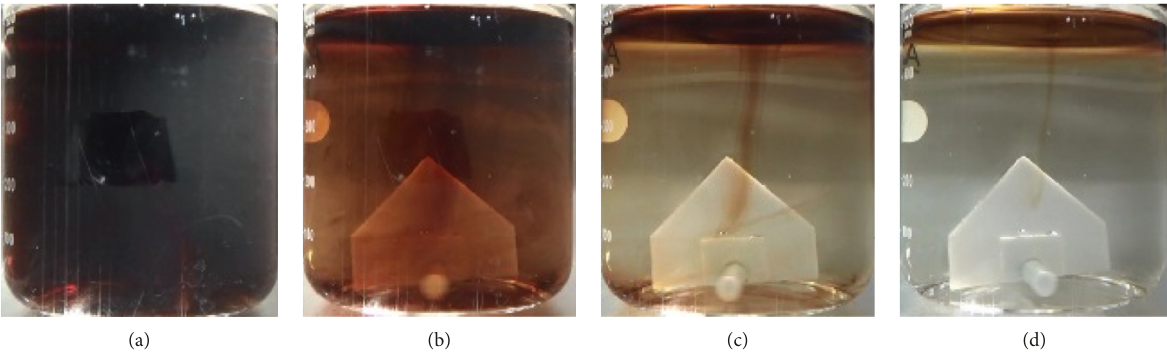
Figure 9: Mixing using an HB-type bar at n � 100rpm (Re � 80). (a) 0s, (b) 10s, (c) 20s, and (d)